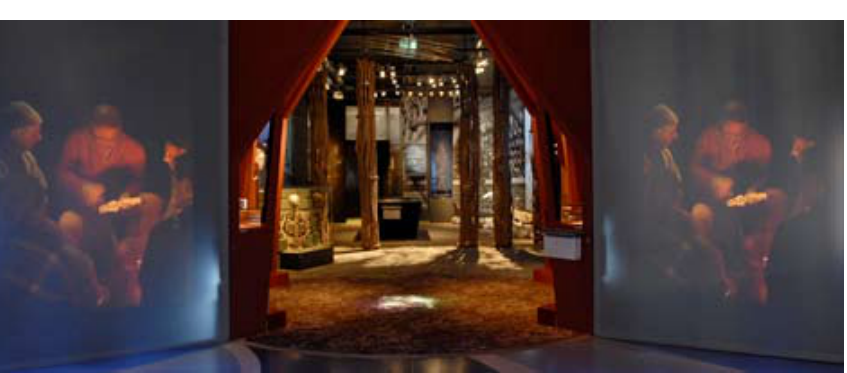
Fig. 1. Prehistories 1, entrance. Photo: Museum of National